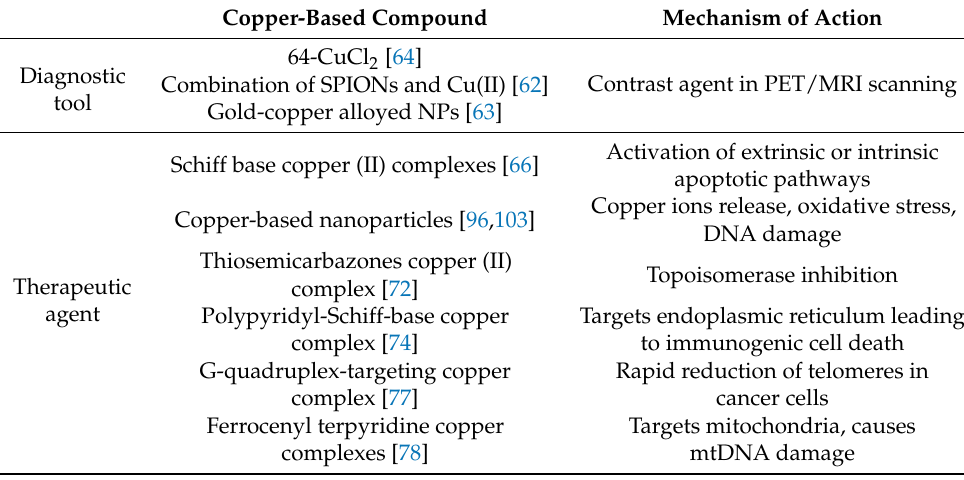
Table 1. Copper-based compounds and nanoparticles with various applications and mechanisms of